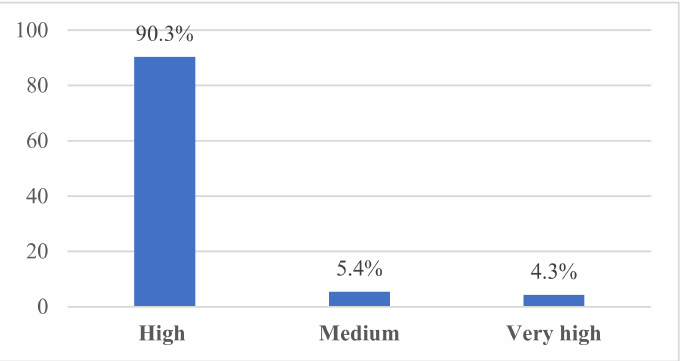
Figure 7. Respondents’ satisfaction level with previous training.